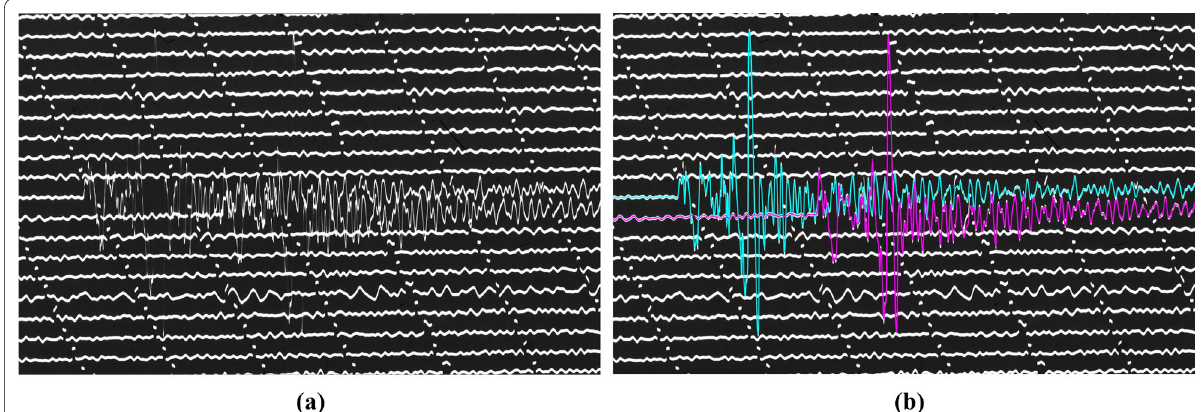
Fig. 6 Digitization Example 3: 1966 Alaskan Twin Earthquakes. A section of long-period north–south recording from COL (College, Alaska) station on December 19, 1966. a Scanned image of 70 mm microfiche as loaded into DigitSeis. b Same image as ( a ) but with digitized traces for lines 12 (cyan) and 13 (magenta) superimposed on the